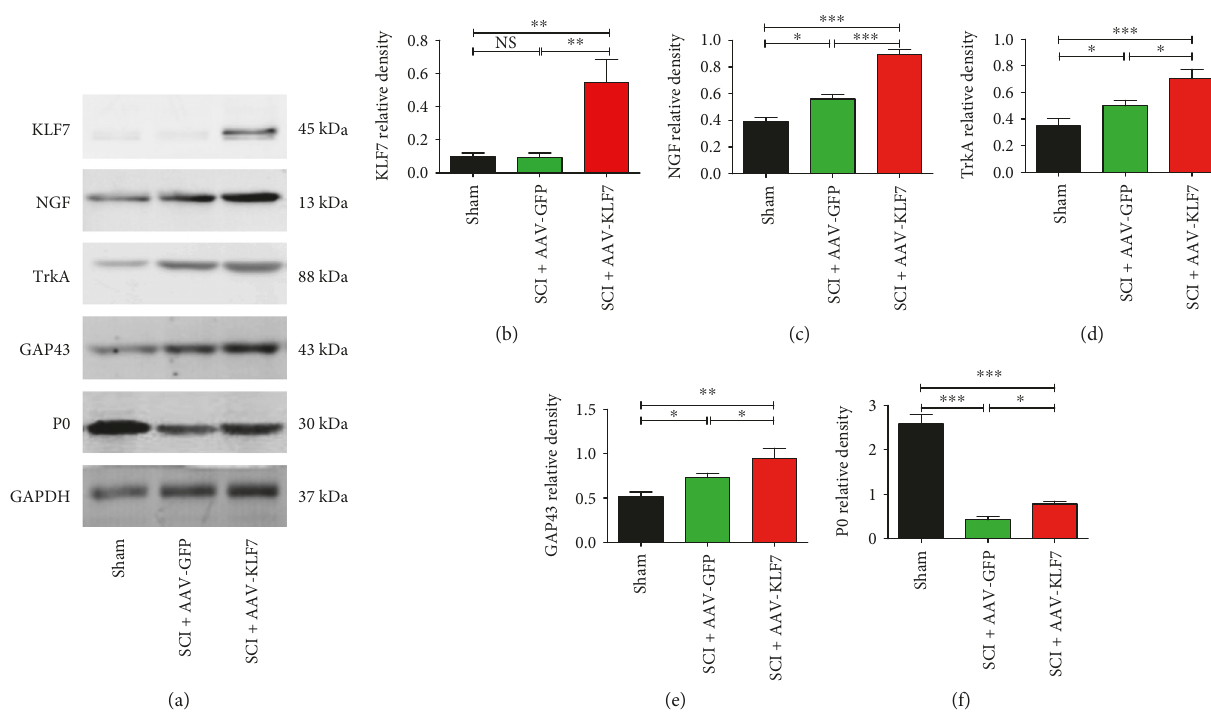
Figure 6: AAV-KLF7 signi fi cantly increased the expression of KLF7 and target proteins NGF, TrkA, GAP43, and P0 following SCI. (a) Representative Western blot analyses of KLF7, NGF, TrkA, GAP43, and P0 expression in thoracic spinal cord section tissues following SCI across three groups. The graphs for the analyses represent the relative density of KLF7 (b), NGF (c), TrkA (d), GAP43 (e), and P0 (f). n = 6 mice/group. Error bars denote SD. ∗ P < 0 05 , ∗∗ P < 0 01 , and ∗∗∗ P < 0 001 . NS: not signi fi cant. One-way ANOVA, Tukey ’ s post hoc